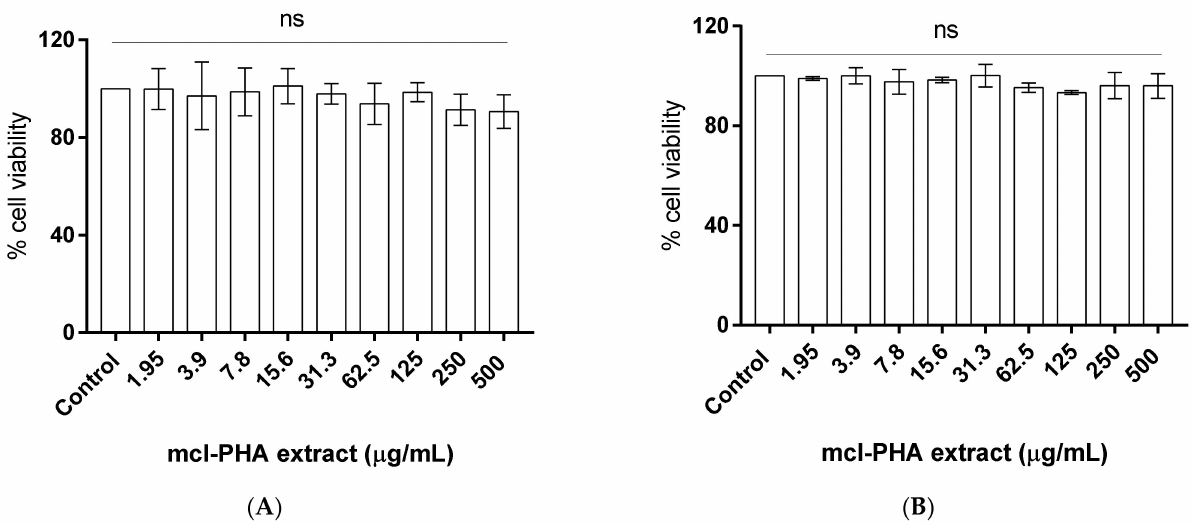
Figure 2. Cytotoxicity evaluation of mcl-PHA extract in ( A ) L929 cells and ( B ) HaCaT cells. Data represent means ± SD ( n = 3). Statistically significant differences were determined by Dunnett’s multiple comparisons test, one-way ANOVA. There were no significant differences between the test groups and the control